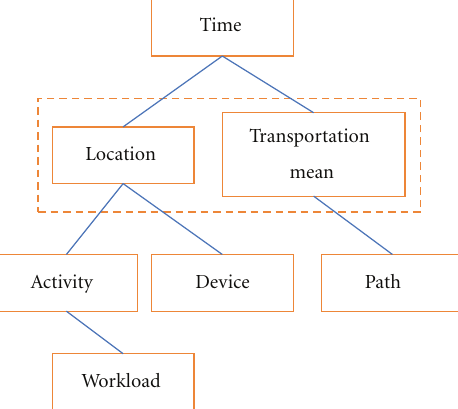
Figure 5: Hierarchical view of contextual